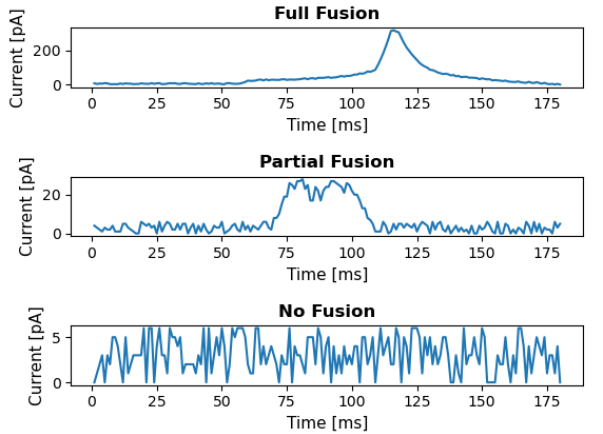
Figure 5. Examples of generated fusion